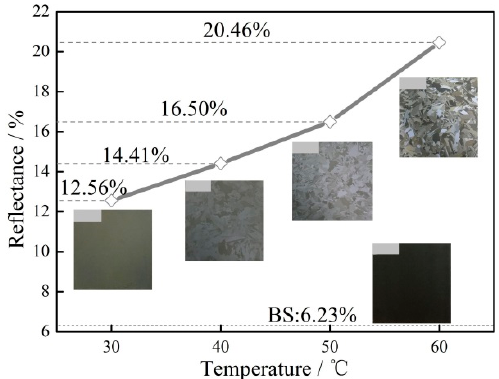
Figure 4. Reflectance values and outline pictures of the NSR treated samples for different times.